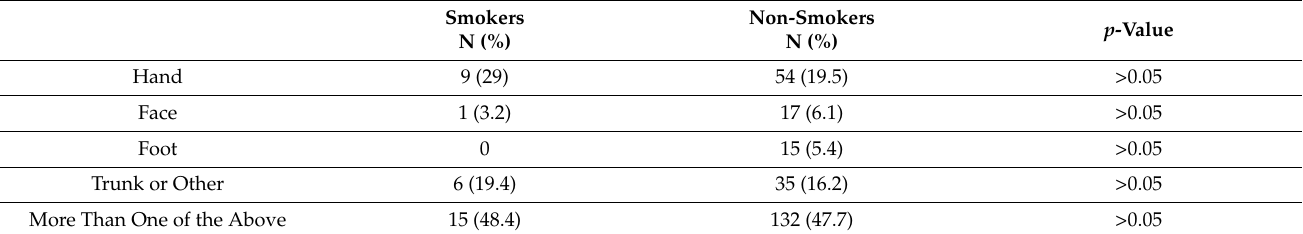
Table 6. Relation between smoking and the affected part of the body by CD.